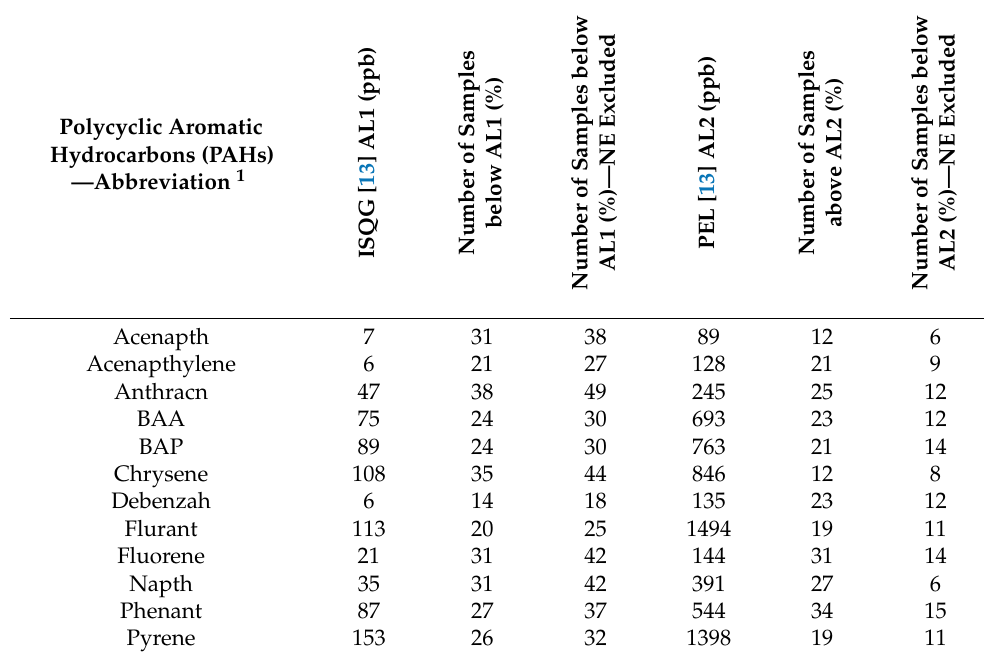
Table 11. Polycyclic Aromatic Hydrocarbons (PAHs)—Individual PAHs—Canadian ISQG/PEL [16]. Percentage of samples below AL1(ISQG) and above AL2 (PEL) and the respective percentage of samples with Northumbria and Humber samples excluded (NE excluded) are presented.